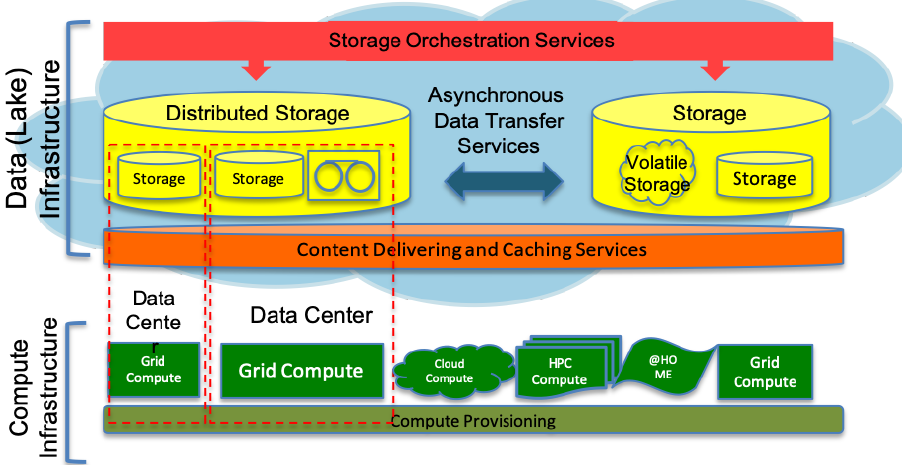
Fig. 1. Diagram showing the building blocks of the datalake infrastructure and the connection with compute services.